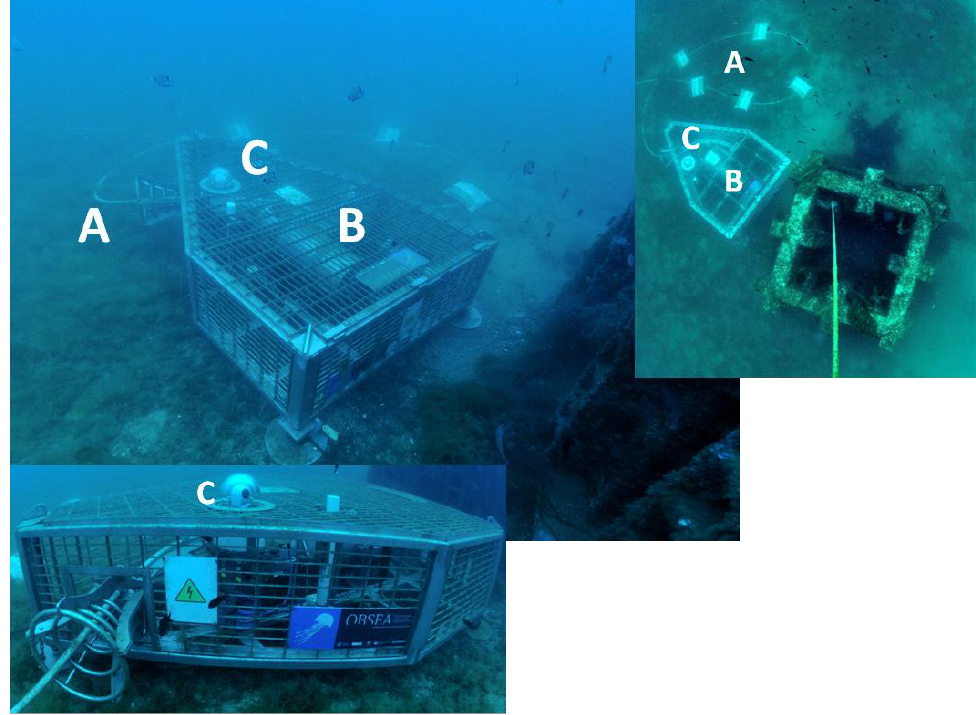
Figure 2. Oblique, vertical, and close lateral views of the OBSEA cabled seafloor observatory showing three structural elements: (A) the cable powering the platform instruments; (B) the junction box within the cylinder holding the installed sensors; and (C) the video imaging system. The concrete column used for studies on faunal colonisation is also visible close the observatory.